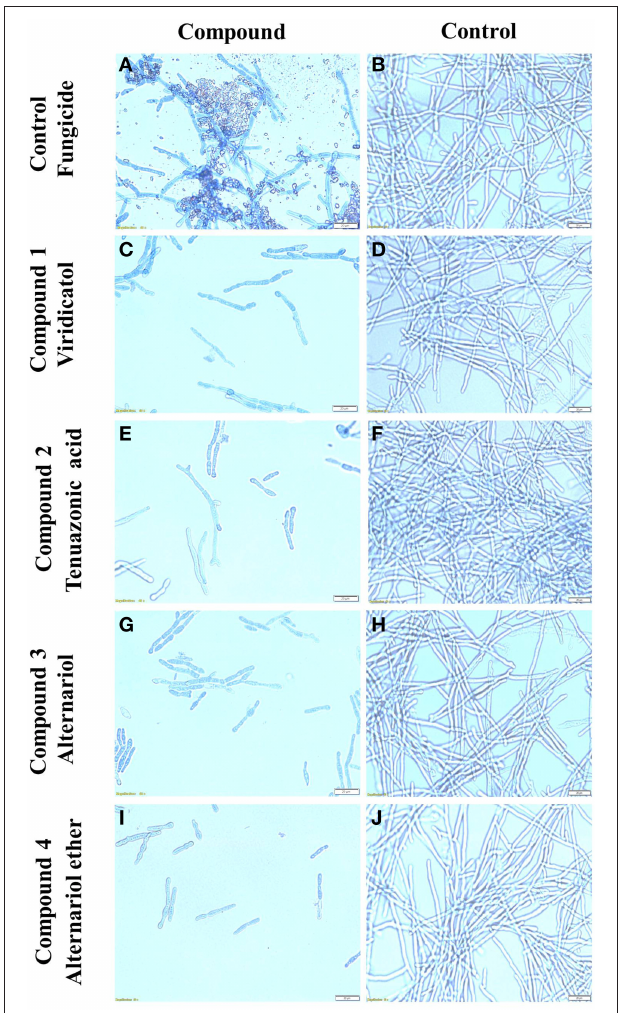
FIGURE 8 | The effects of the purified compounds on F. graminearum in vitro using Evans blue staining. Shown are representative microscope slide pictures ( n = 3 ) of the interactions of F. graminearum with: (A) the fungicide PROLINE compared to (B) the buffer control; (C) viridicatol compared to (D) the buffer control; (E) tenuazonic acid compared to (F) the buffer control; (G) alternariol compared to (H) the buffer control; (I) alternariol monomethyl ether compared to (J) the buffer control. In (A) , the aggregated particles between the hyphae are precipitates of